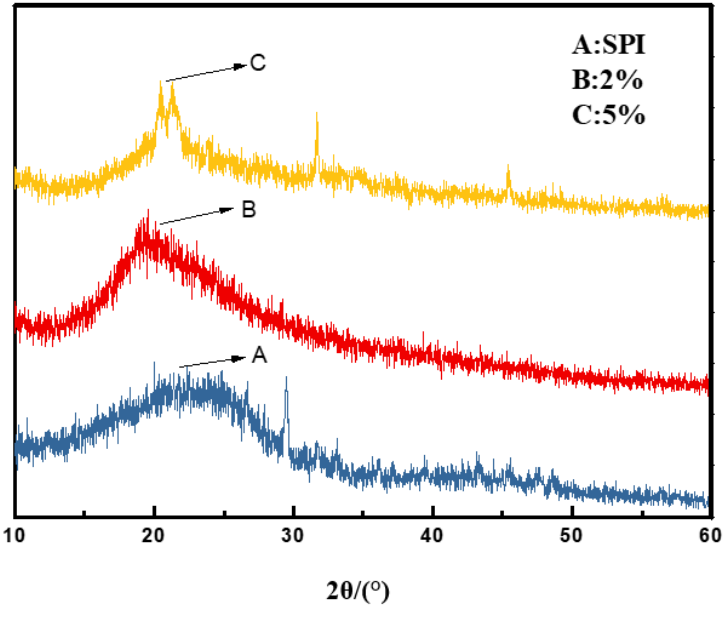
Figure 13. XRD diffraction pattern. Figure 13. XRD di ff raction